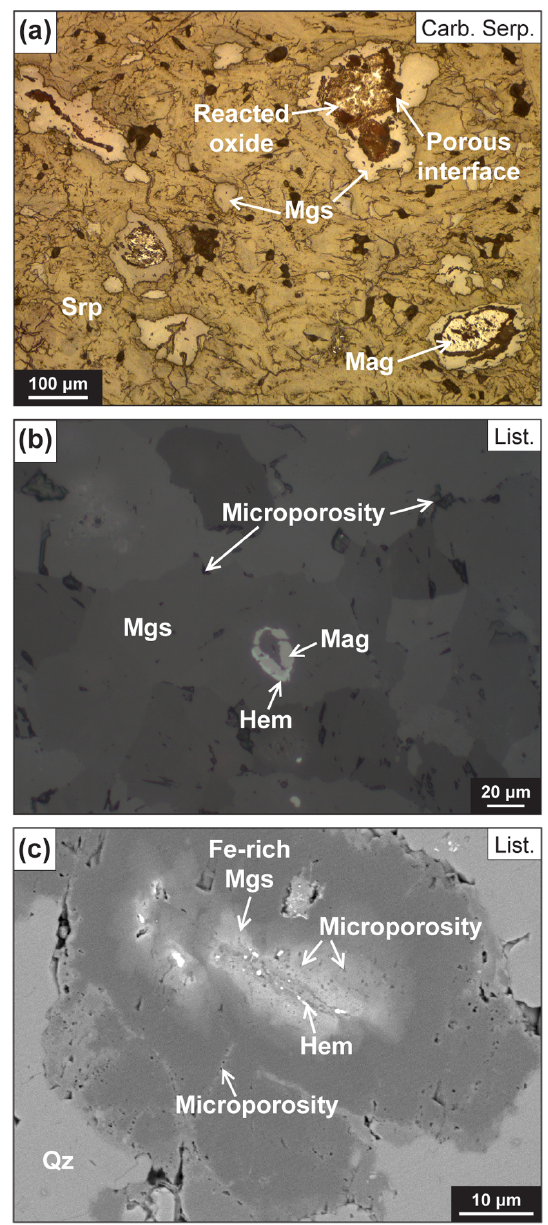
Figure 4. Textural relationships between Fe oxides and magnesite. (a) Reflected light (RL) image of spheroids in carbonated serpenti- nite OM20-26. Magnesite surrounding variously reacted Fe oxides (“reacted oxide”) and magnetite. A porous interface connects oxide relicts and magnesite. (b) Magnetite destabilized into hematite and overgrown by magnesite aggregate in listvenite 71Z-2-21-26. Pres- ence of a microporosity along (sub-)grain boundaries. (c) Internal Fe zoning of Fe-core spheroid, with hematite and a microporous zone outlining the relict of reacted Fe oxide. Abbreviations: Hem: hematite; Mag: magnetite; Mgs: magnesite; Qz: quartz; Srp: serpen-